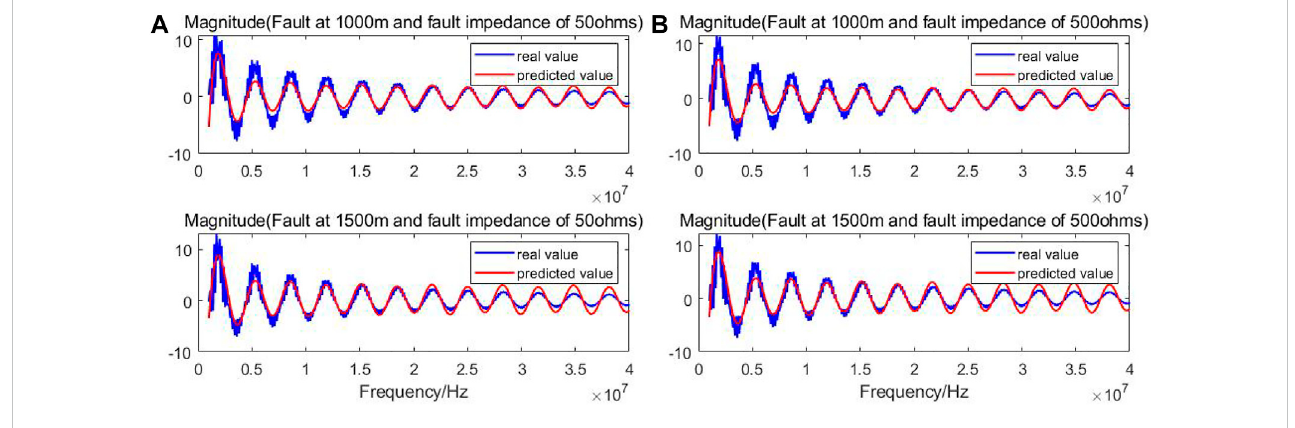
FIGURE 13 Input impedance values of different faults at different locations.